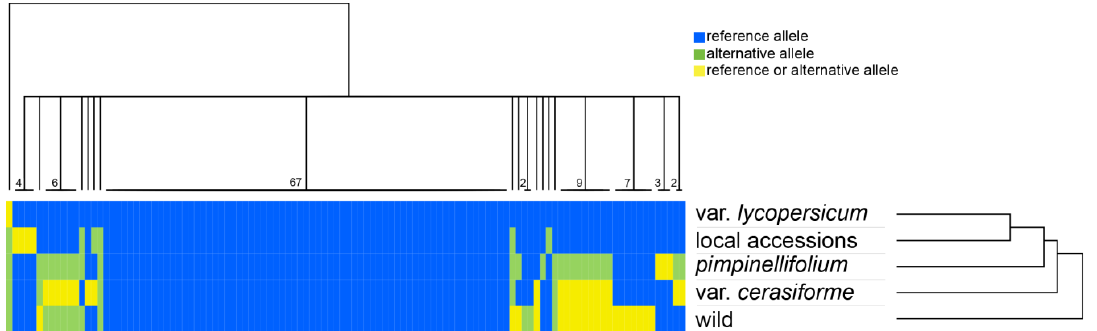
Figure 3. Hierarchical clustered heatmap representing color-coded simple sequence repeat (SSR) alleles as scored across 5 different groups of genotypes, i.e., var. lycopersicum ; local accessions; S. pimpinellifolium ; var. cerasiforme ; wild species (including S. habrochaites , S . cheesmaniae , and S. galapagense ). Numbers at the base of the tree indicate the SSR(s) that fall into each group. Blue: reference allele; green: alternative allele; yellow: reference or alternative allele.